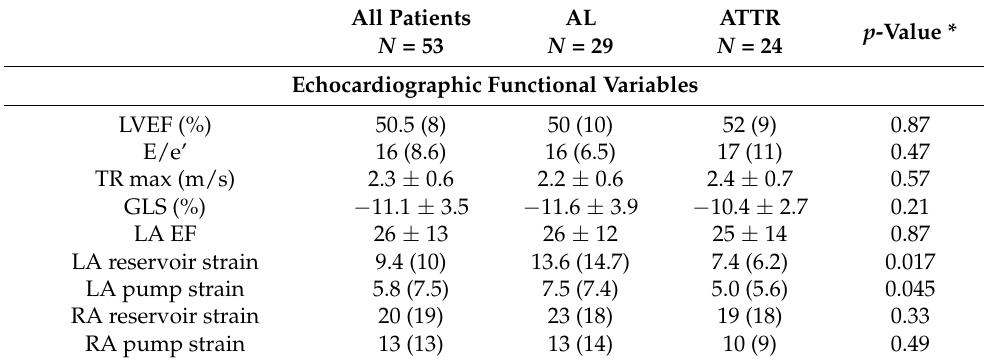
Table 3. A comparison of the echocardiographic functional variables between the immunoglobulin light chain and transthyretin cardiac amyloidosis